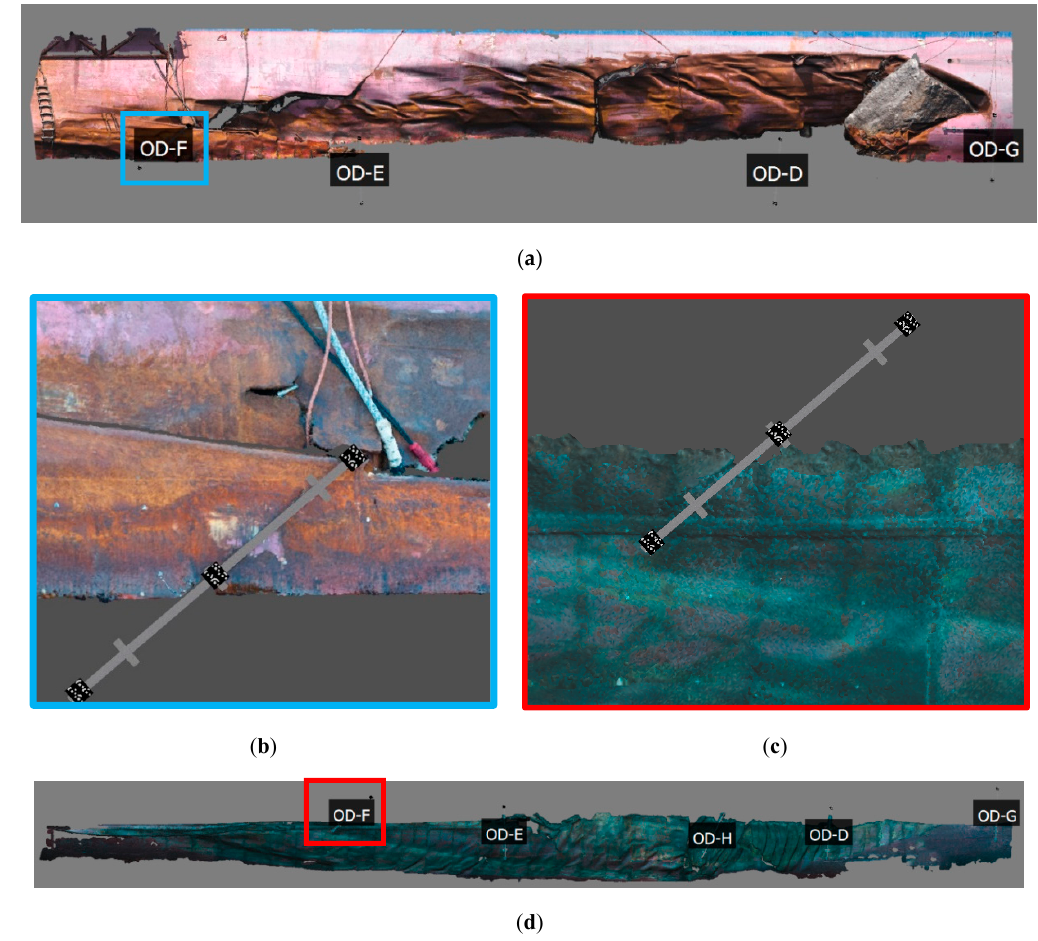
Figure 12. Alignment of all the ODs on the above the water ( a ) and underwater ( d ) photogrammetric models. ( b ) and ( c ) show particulars of the alignment of OD-F.